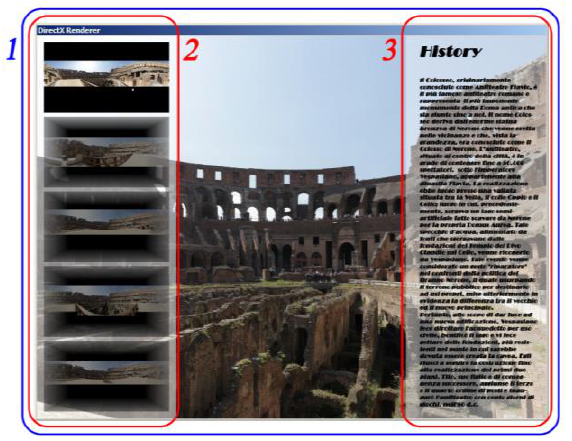
Figure 7. VR tool for the interactive navigation of the acquired panoramas. GUI (1), buttons with panorama preview (2) and additional information (3)